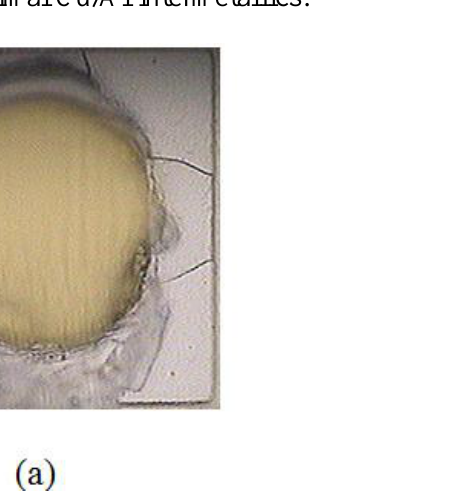
Figure 7. Optical micrographs showing ( a ) good ball pad coverage with Au intermetallics and ( b ) very minimal Cu/Al